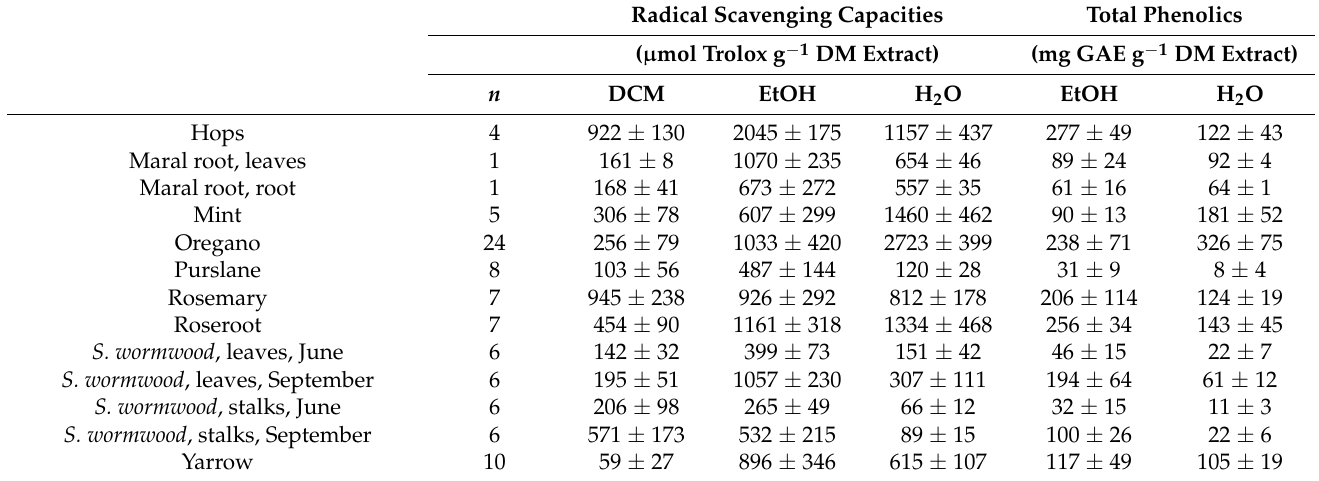
Table 2. Scavenging capacities of the ABTS-radical measured as Trolox equivalents (TEAC) and total phenolic content of dried extracts from herbs successively extracted with DCM followed by EtOH and H 2